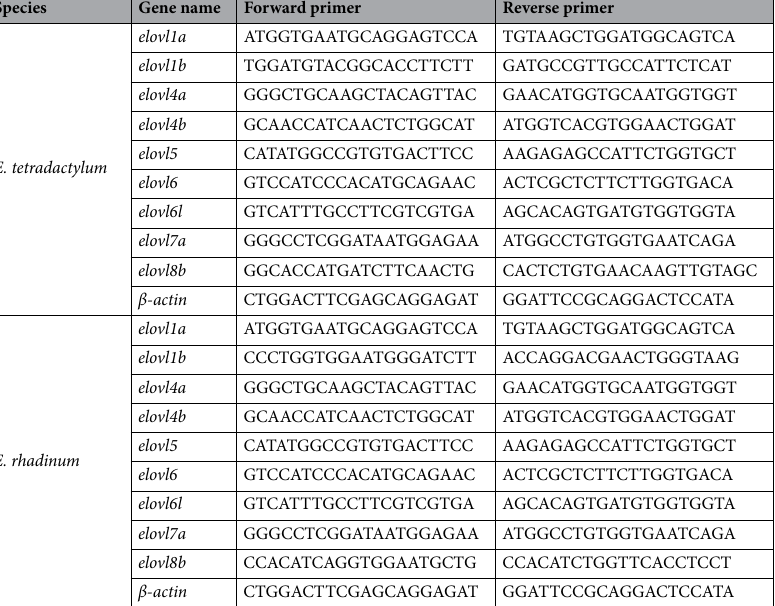
Table 1. Gene-specific primers for